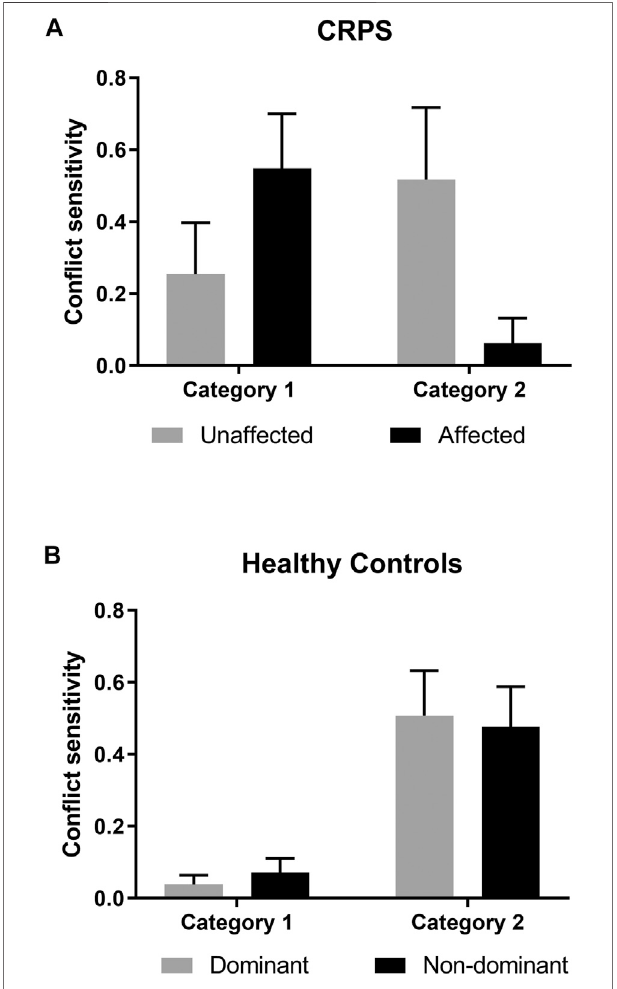
FIGURE 2 | Con fl ict sensitivity according to the CRPS (A) and Healthy Controls (B) groups. Category 1 (cid:1) pain, discomfort, lost limb, temperature, weight;Category2 (cid:1) peculiarity,losingcontrol,extralimb.Meanandstandard deviation of the mean are reported.